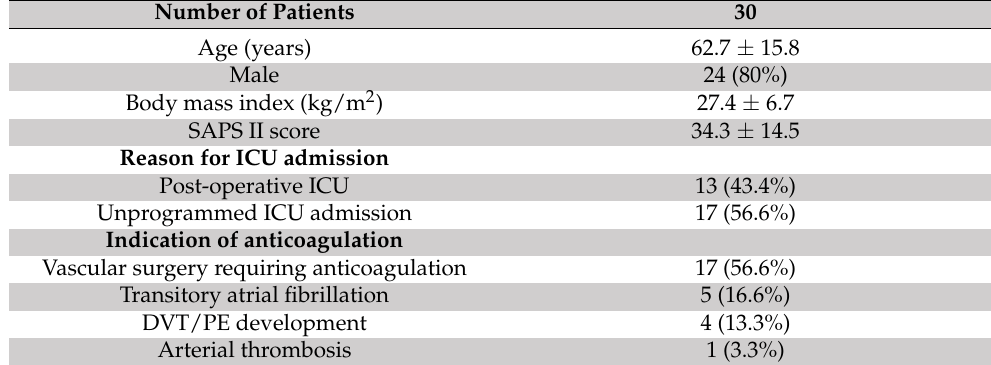
Table 1. Characteristics of the population . Data are presented as absolute (%) or mean ( ± SD) values. ICU: intensive care unit. SAPS II: simplified acute physiology score II. aPTT: activated partial thrombin time. CRP: C reactive protein. DVT: Deep Vein Thrombosis. PE: Pulmonary